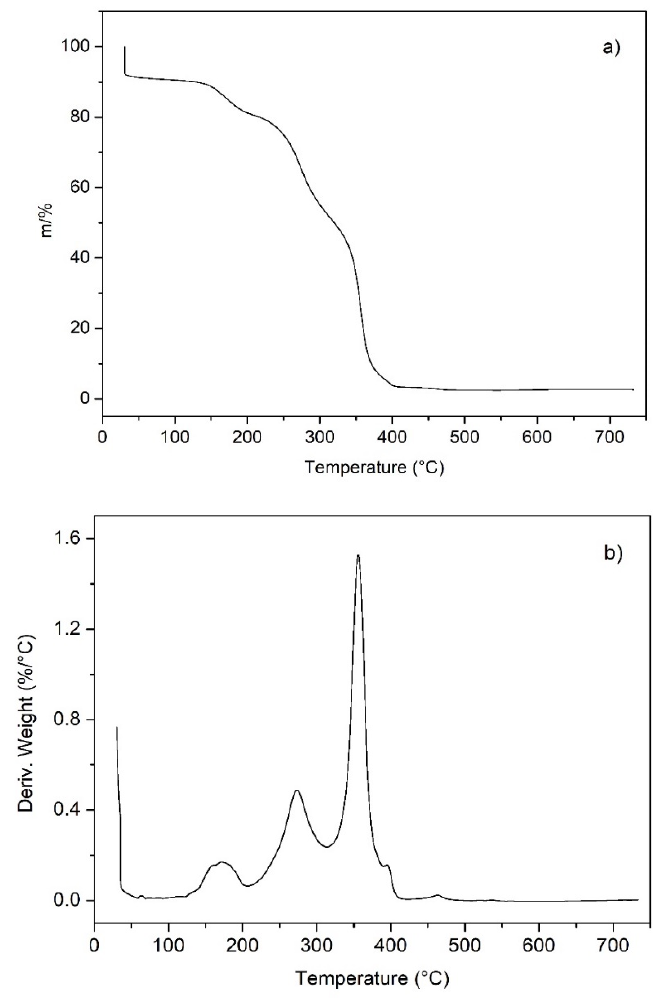
Figure 7. ( a ) High-resolution thermogram of the crosslinked ionomer in air; ( b ) derivative curve.